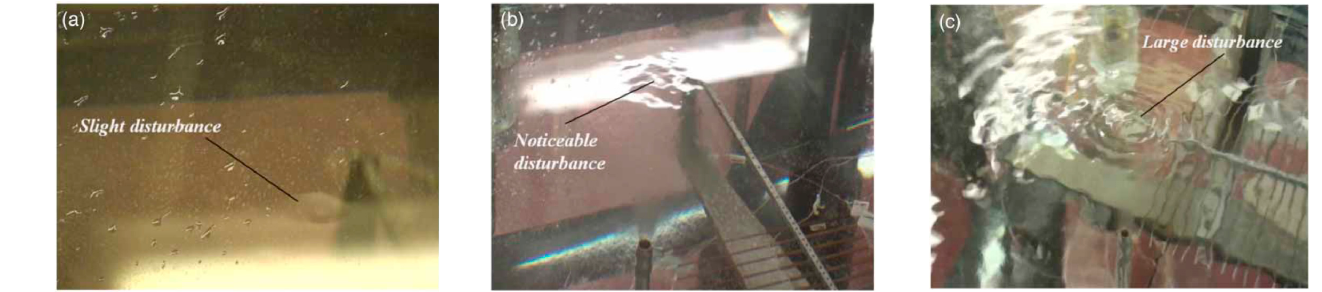
Figure 5. Top view of water surface disturbance observed in the experimental study for H / r 0 = 37.2 and ( a ) Fr = 10.9, ( b ) Fr = 18.2, and ( c ) Fr = 24.2 ([11]; Reprinted from Water Science and Technology, volume 73, issue number 12, pages 2986–2997, with permission from the copyright holders, IWA Publishing).